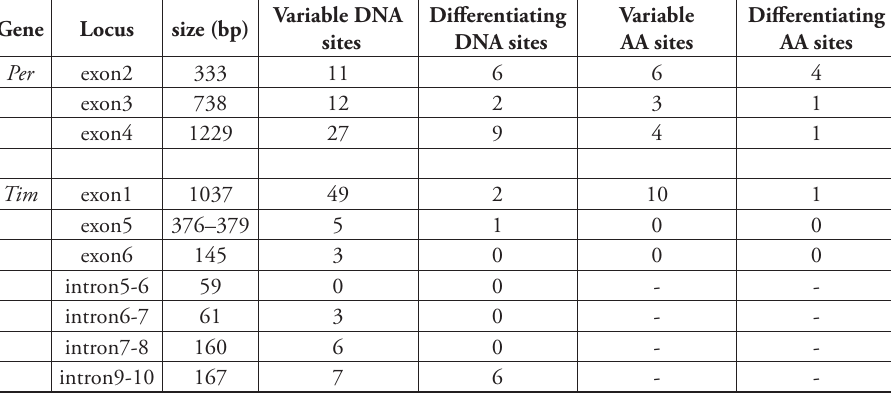
Table 3. Comparison of exons and introns variability between C. pipiens f. “pipiens” and f. “molestus” from